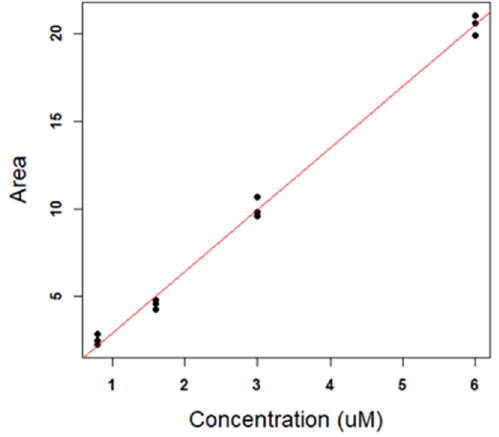
Figure 6. Linear regression in the concentration range 0.8–6 µM . Table 5. Linear regression parameters. All values are reported with the corresponding measure unit, AU stands for (FLD) area unit.